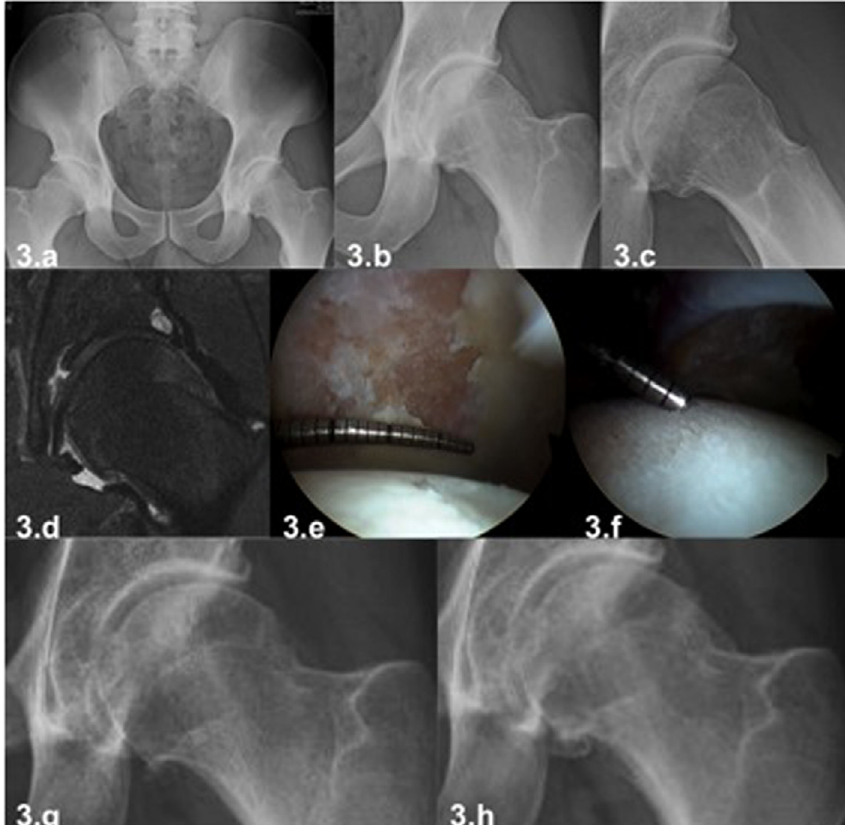
Figure 3. Male patient, age 32 years, intensive recreational athlete (triathlon, mountain climbing) with left hip pain in flexion and rotational movements. Clinical examination demonstrates a restriction of internal rotation in flexion above 90 (cid:3) associated with pain (anterior impingement). The radiograph demonstrates a FAI with a cam deformity and joint space narrowing in the peripheral joint area (3a–3c). The MRI showed a chondrolabral lesion and acetabular subchondral cyst (3d). Considering his young age and his rejection to a THR a hip arthroscopy was performed. Full-thickness chondral damage in acetabulum (3e) and diffuse fibrillation of cartilage in femoral head was found during the arthroscopy (3f). These should be considered an advanced osteoarthritis finding with a very unpredictable clinical outcome. The radiography one year later shows the progression of the chondral damage of the hip (3g). This case shows that with hip arthroscopy a temporary relief of pain can be achieved in cases of advanced chondral damage but it cannot change the course of the disease and progression to osteoarthritis of the